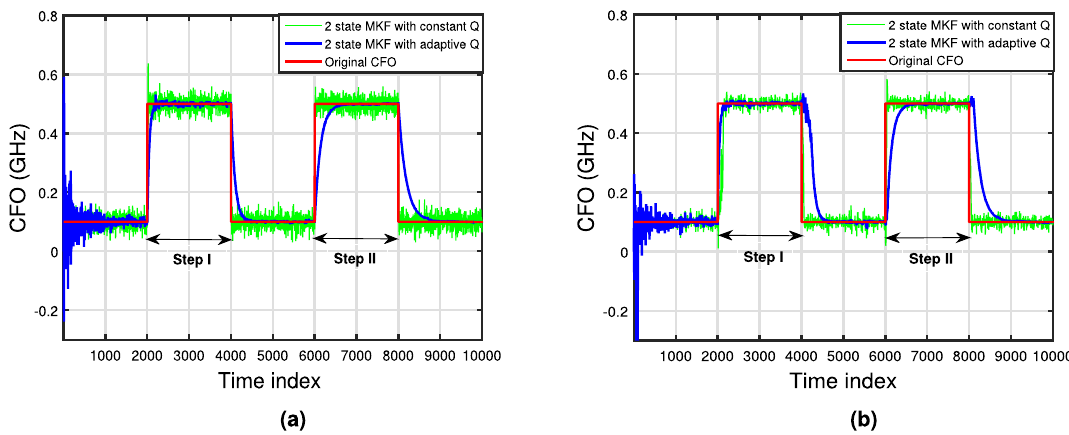
Figure 12. Tracked CFO by 2 state MKF with constant Q and adaptive Q for ( a ) m = 1 and ( b ) m = 3.